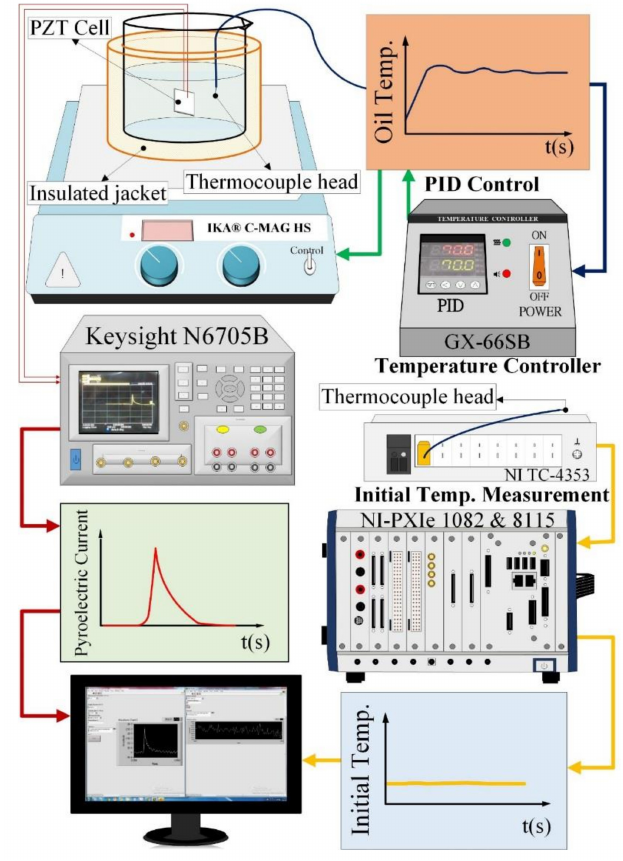
Figure 2. A measurement setup for estimating the PZT entropy sensors.